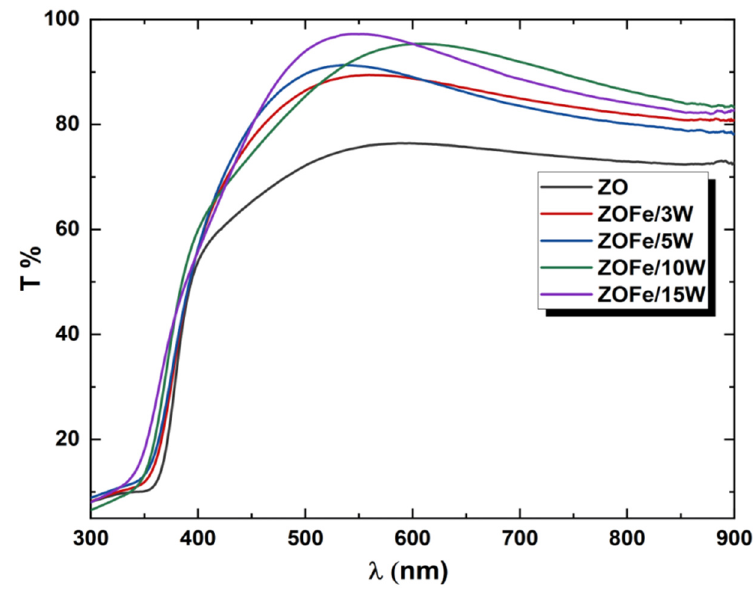
Figure 7. Transmittance of ZO and ZOFe thin films.